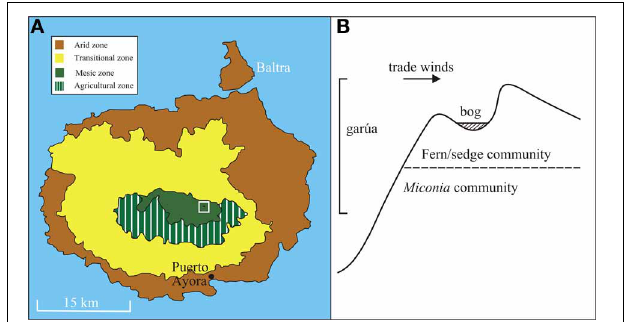
FIGURE 1 | (A) Map of Santa Cruz island with associated vegetation zones and agricultural zone within mesic zone highlighted. Paul’s Bog (black ellipse) located within white box. (B) Diagram of slope of valley with Paul’s Bog at the peak with trade wind direction, garúa location and vegetation communities